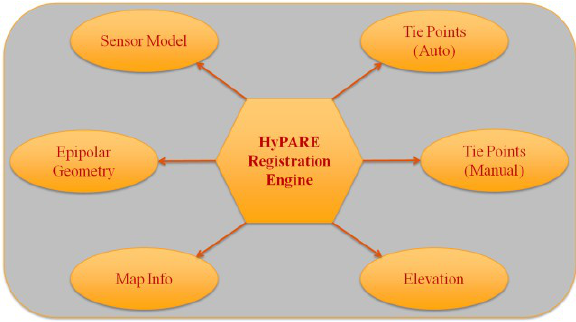
Figure 1. Key components of the Hybrid Powered Auto- Registration Engine